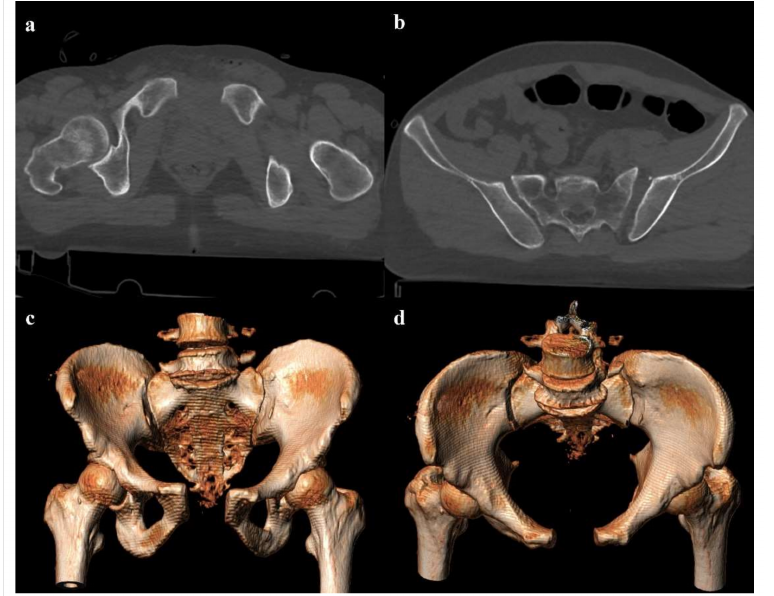
Figure 6. Anterior–posterior compression fracture, type 3. Axial CT images ( a , b ) and three- dimensional volume-rendering CT reconstructions in AP and inlet views ( c , d ) show a pubic symph- ysis diastasis of 4.2 cm, anterior and posterior left side sacroiliac joint diastasis, and anterior widening of the right sacroiliac